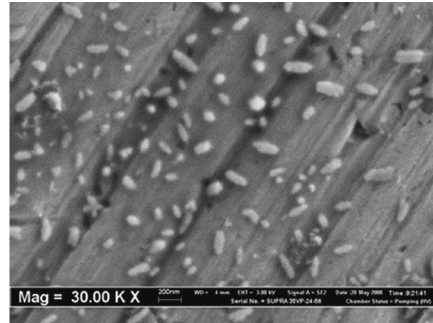
Figure 7: SEM micrograph of the fractured surface of pure PP